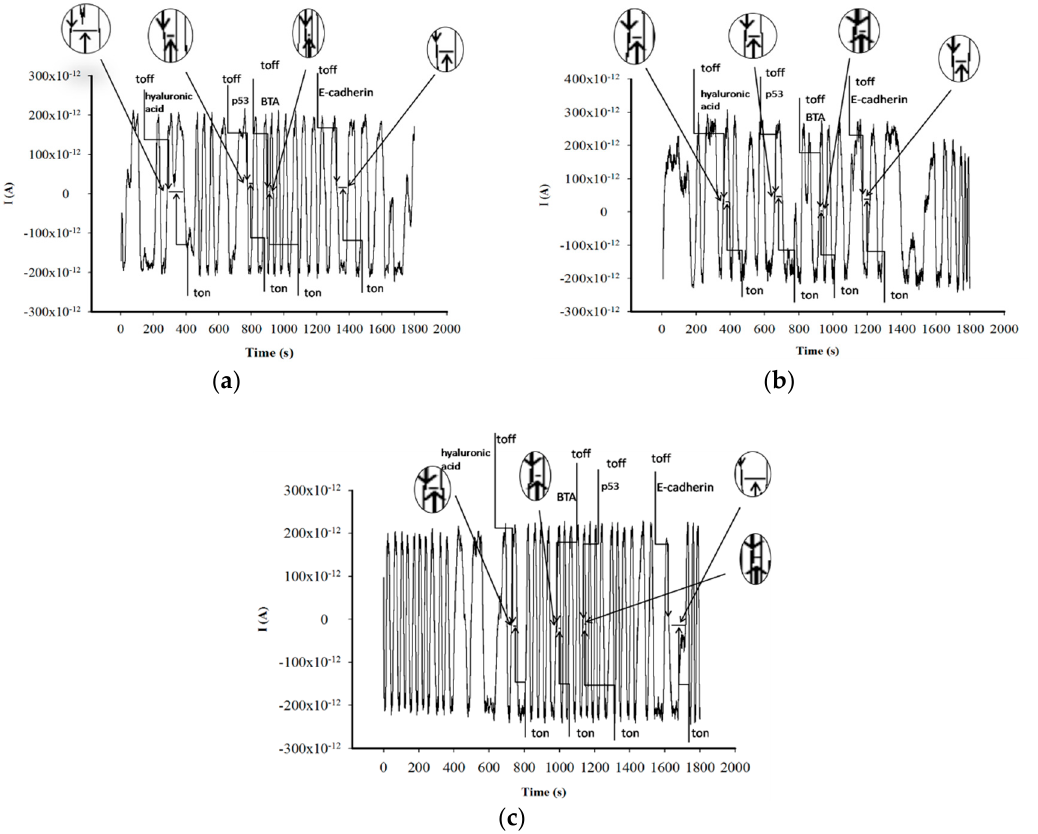
Figure 1. Pattern recognition of p53, E-cadherin, BTA, and hyaluronic acid in whole blood samples using the stochastic needle sensor based on chitosan I/graphite ( a ), chitosan II/graphite ( b ), and chitosan III/graphite ( c ).